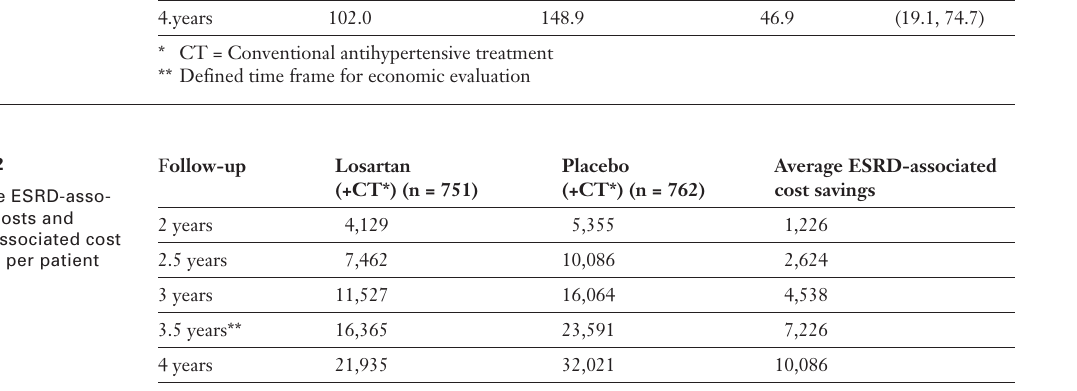
Average number of ESRD days and days of ESRD saved per patient.